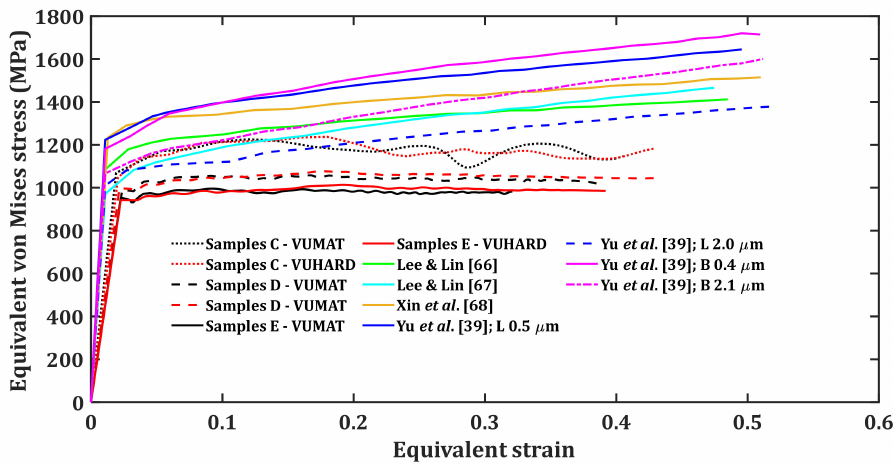
Figure 14. Results of SHPB test simulation at an impact velocity of 25 m/s and a temperature of 25 ◦ C with the test samples modelled using various sets of J–C model parameters (note: B and L stand for bimodal and lamellar microstructures, respectively) and the numerical models developed in the present